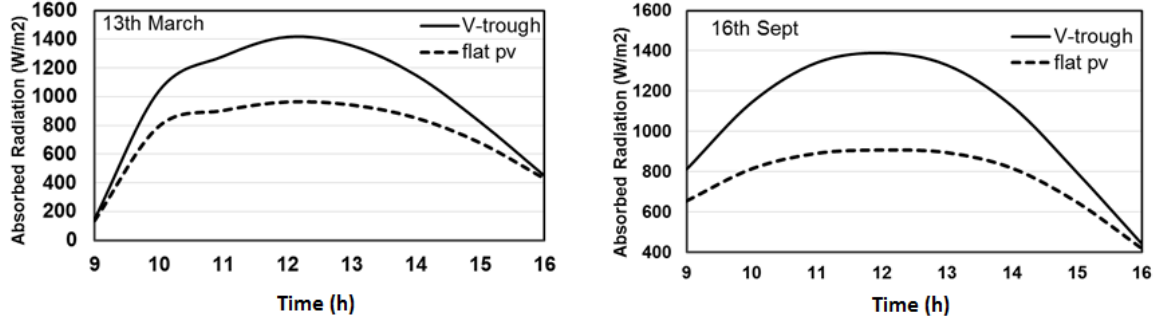
Figure 9. Comparison of absorbed radiation intensity for V-trough PV system and simple PV panel.